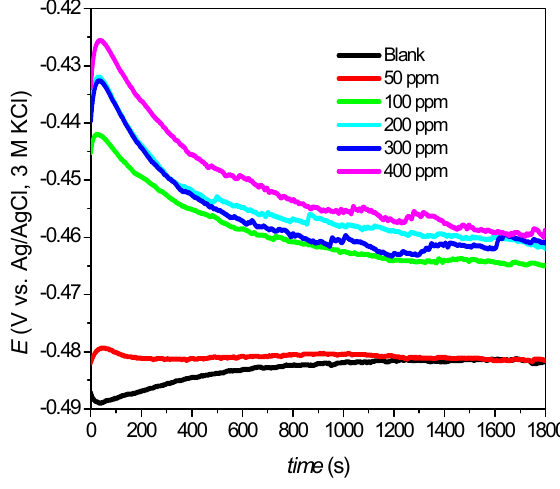
Figure 1. OCP scan for mild steel corrosion in 1 M HCl with and without various concentrations of